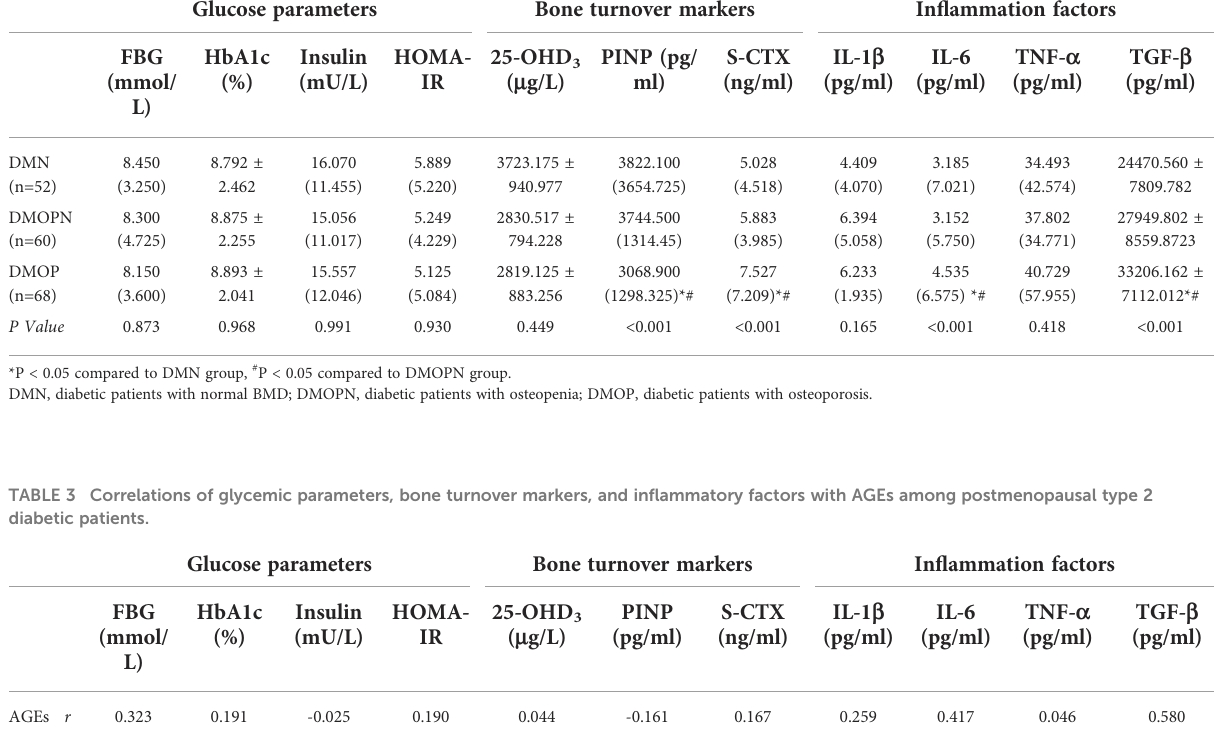
TABLE 2 Glucose parameters, bone turnover markers, and in fl ammation factors comparation among DMN, DMOPN and DMOP groups. Glucose parameters Bone turnover